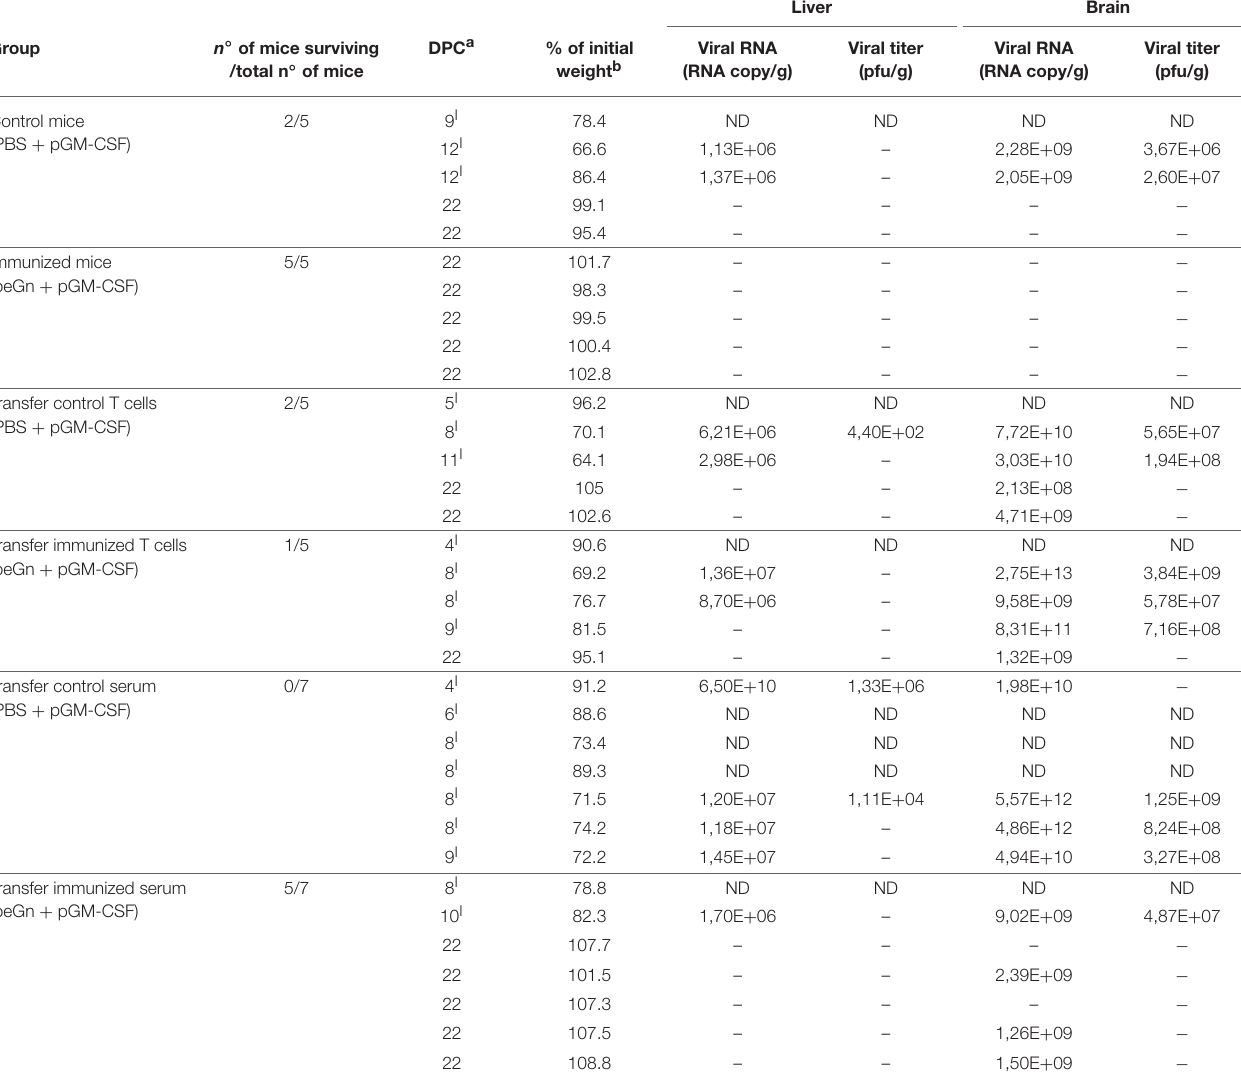
TABLE 1 | Protection mediated by the T cells or sera from peGn-immunized mice upon RVFV